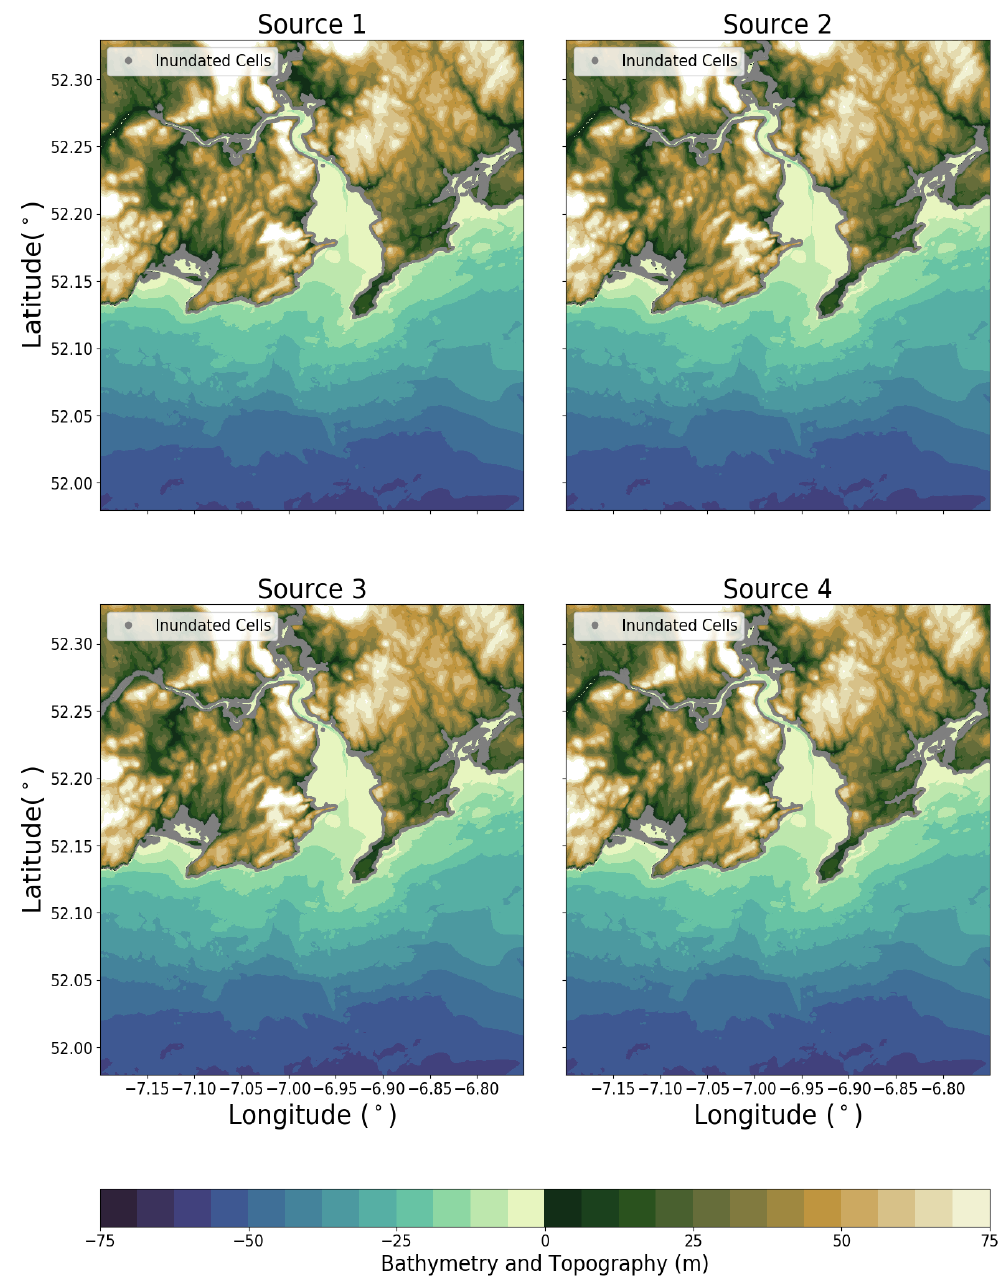
Figure 11. Inundation maps for Dunmore East for the various tsunami sources. The grey areas on the map are land values which were inundated during the